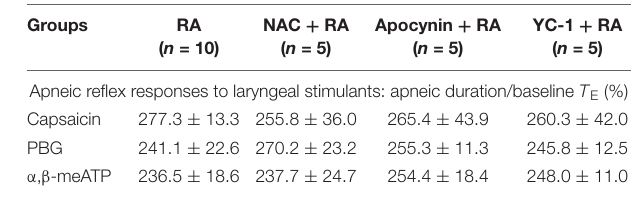
TABLE 1 | Average apneic responses to laryngeal chemical stimulants in various study